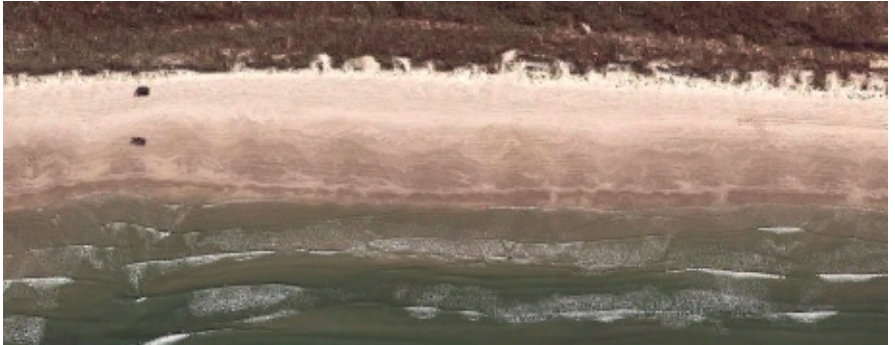
Figure 2. Texas Beach (Image Source: Google Maps).